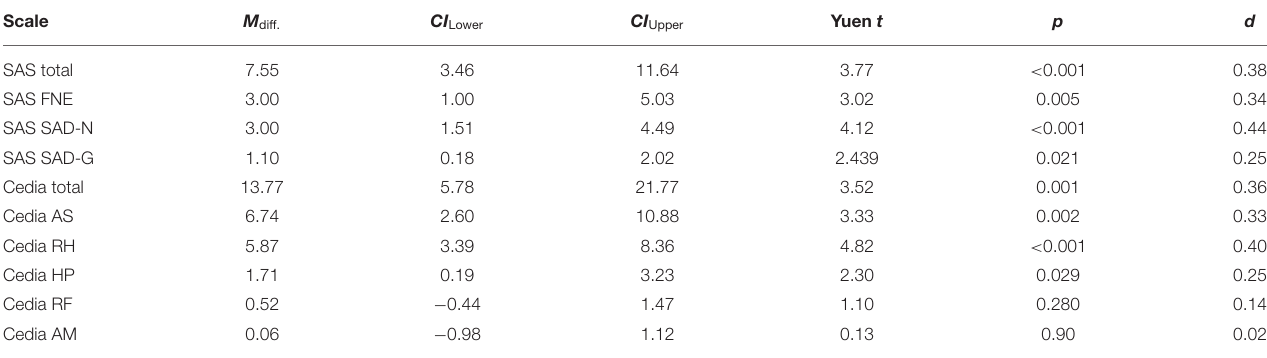
TABLE 1 | Robust t statistics for SAS and CEDIA subscales main effects before and after treatment. Scale M diff.